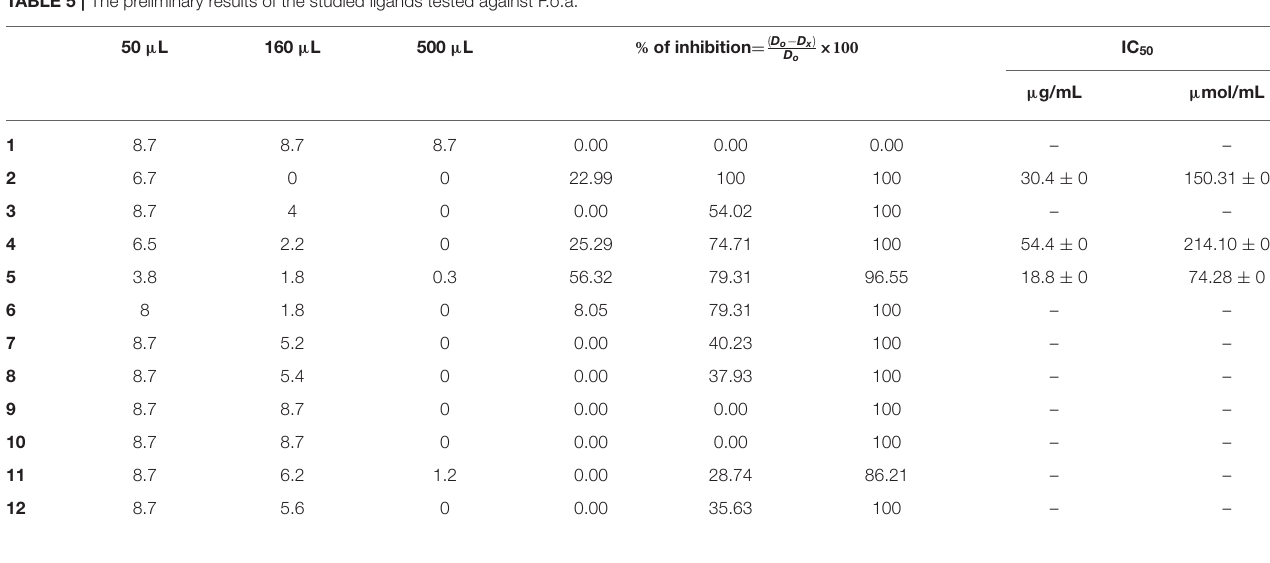
TABLE 5 | The preliminary results of the studied ligands tested against F.o.a. 50 µ